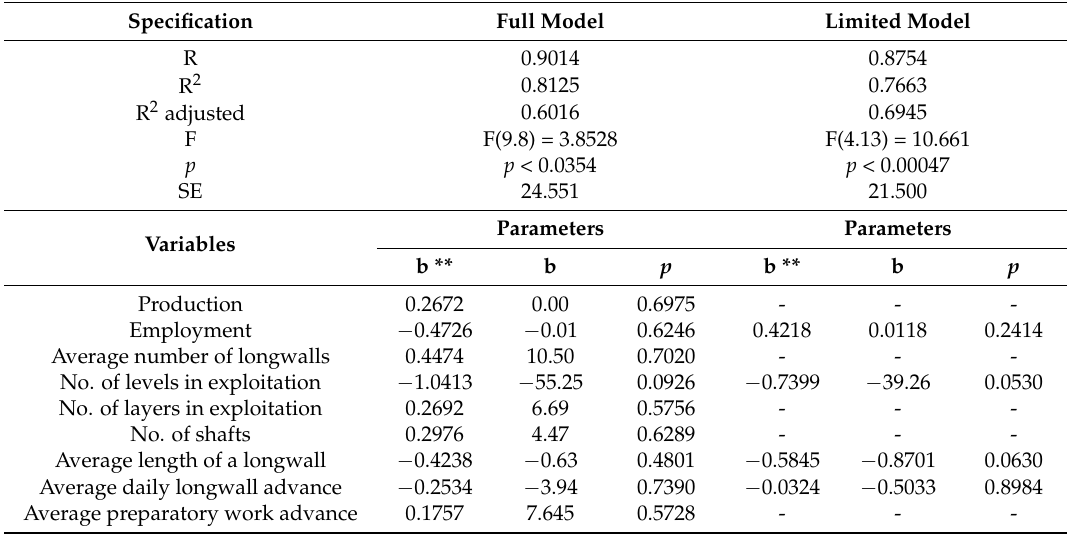
Table 4. Regression models for